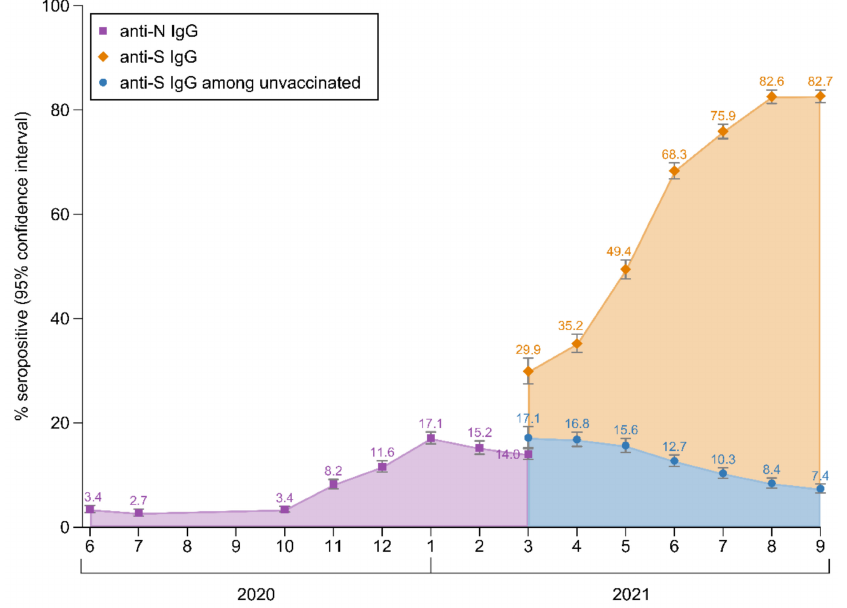
Figure 1. Seroprevalence of anti-SARS-CoV-2 IgG antibodies in Tyrolean blood donors aged 18–70 years; Tyrol, Austria; June 2020–September 2021 (n = 35,193). The analysis involved data from 47,363 blood donations taken from 35,193